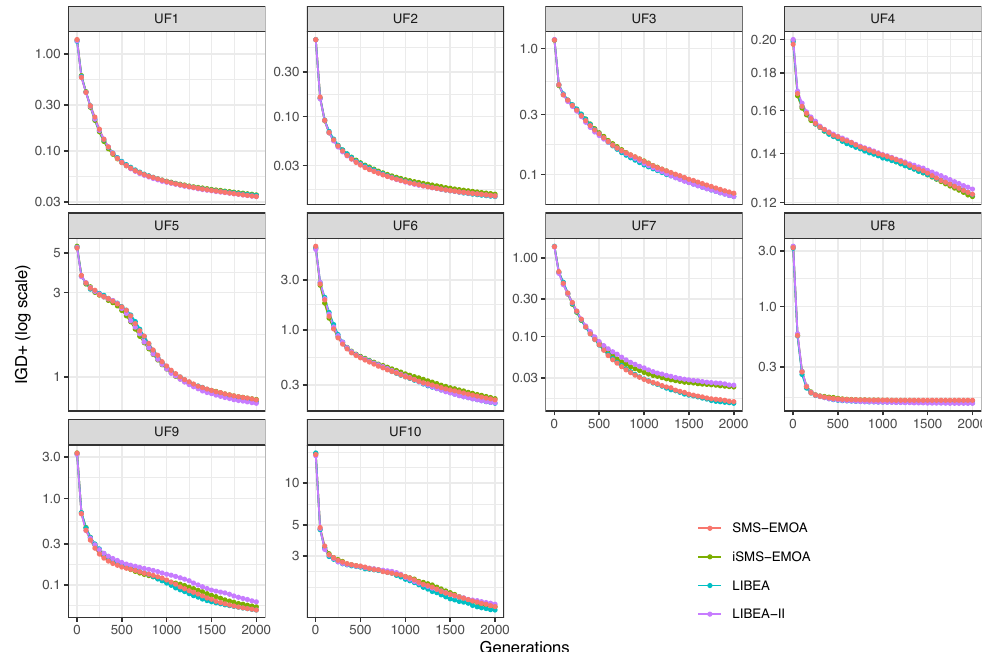
Figure 1. Convergence plots of the IGD + quality indicator on the UF test problems.